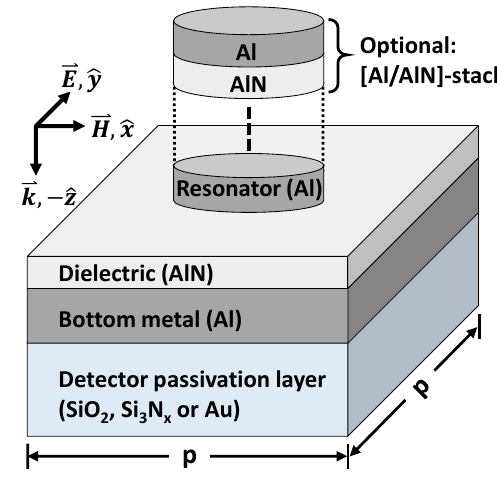
Figure 1. Schematic illustration of the unit cell in the numerical